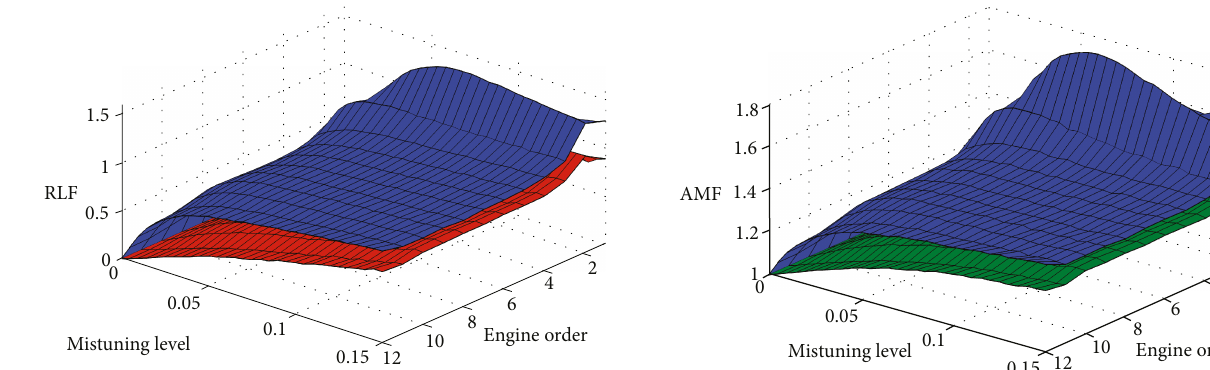
Figure 15: Sensitivity to engine orders and mistuning levels.